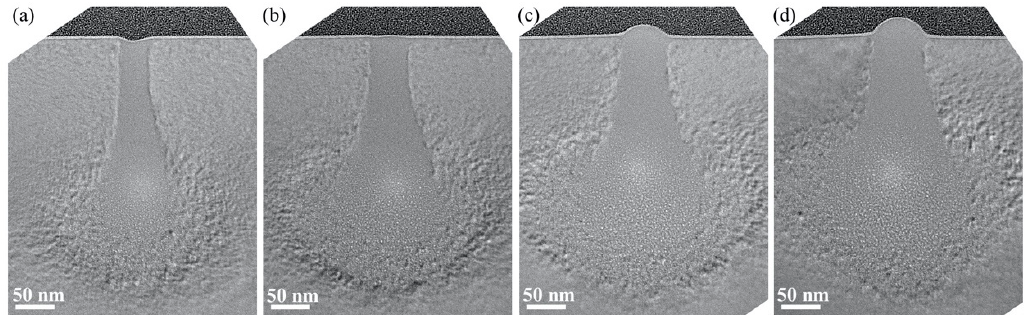
Figure 7. TEM images of cross-section samples of silicon substrates treated with He-FIB at a beam energy of 25 keV: ( a ) Ion dose of 0.02 nC/ μ m; ( b ) Ion dose of 0.03 nC/ μ m; ( c ) Ion dose of 0.04 nC/ μ m; ( d ) Ion dose of 0.05 nC/ μ m.